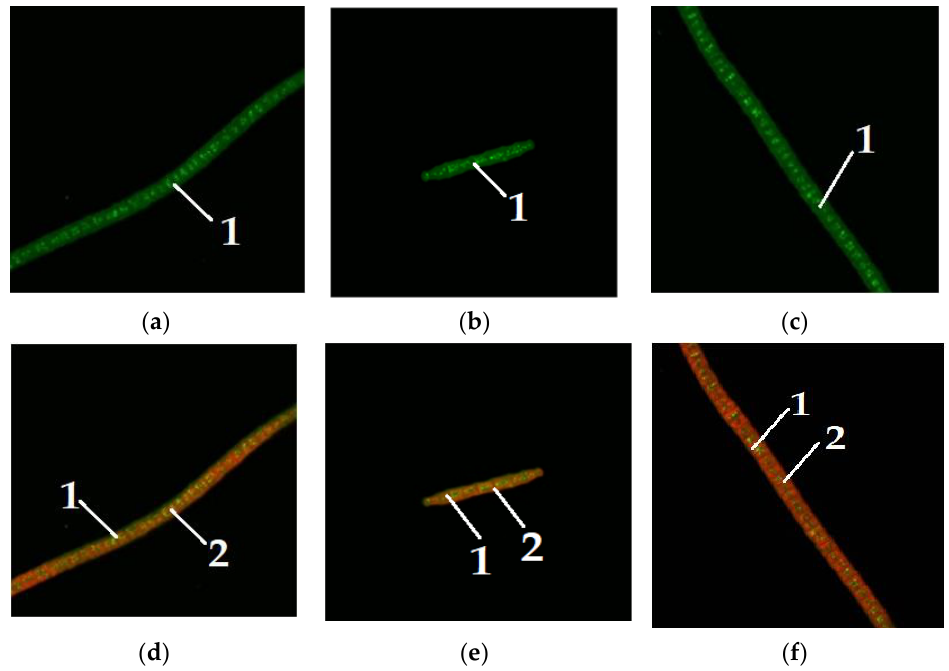
Figure 5. Microalgae Arthrospira platensis when glucose was added to the nutrient medium (1 – lipid droplet, 2 – chlorophyll): ( a – c ) visualization of lipids; ( d – f ) visualization of chlorophyll. Figure 6 shows the staining of lipids with dyes in microalgae Arthrospira platensis when maltose is added to nutrient media. when fructose is added to nutrient